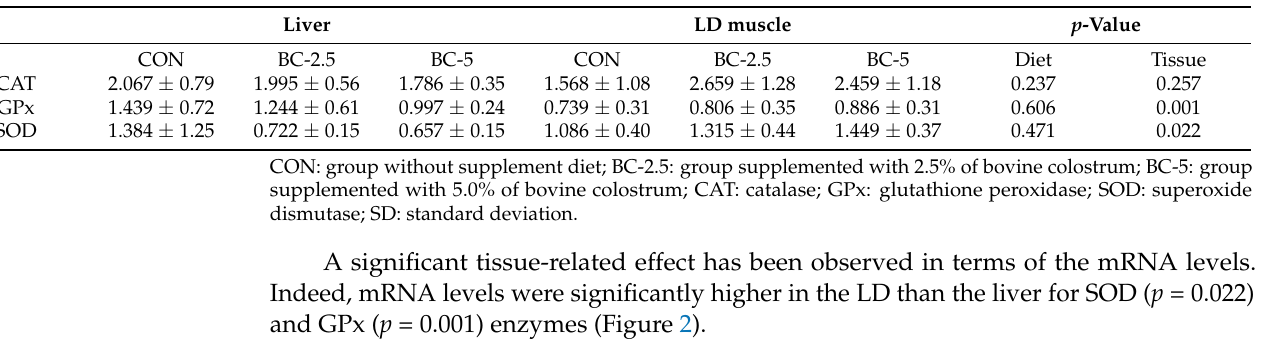
Table 5. mRNA relative quantification of the antioxidant enzymes CAT, GPx and SOD in the liver and LD muscle of rabbits (values are given as means ±